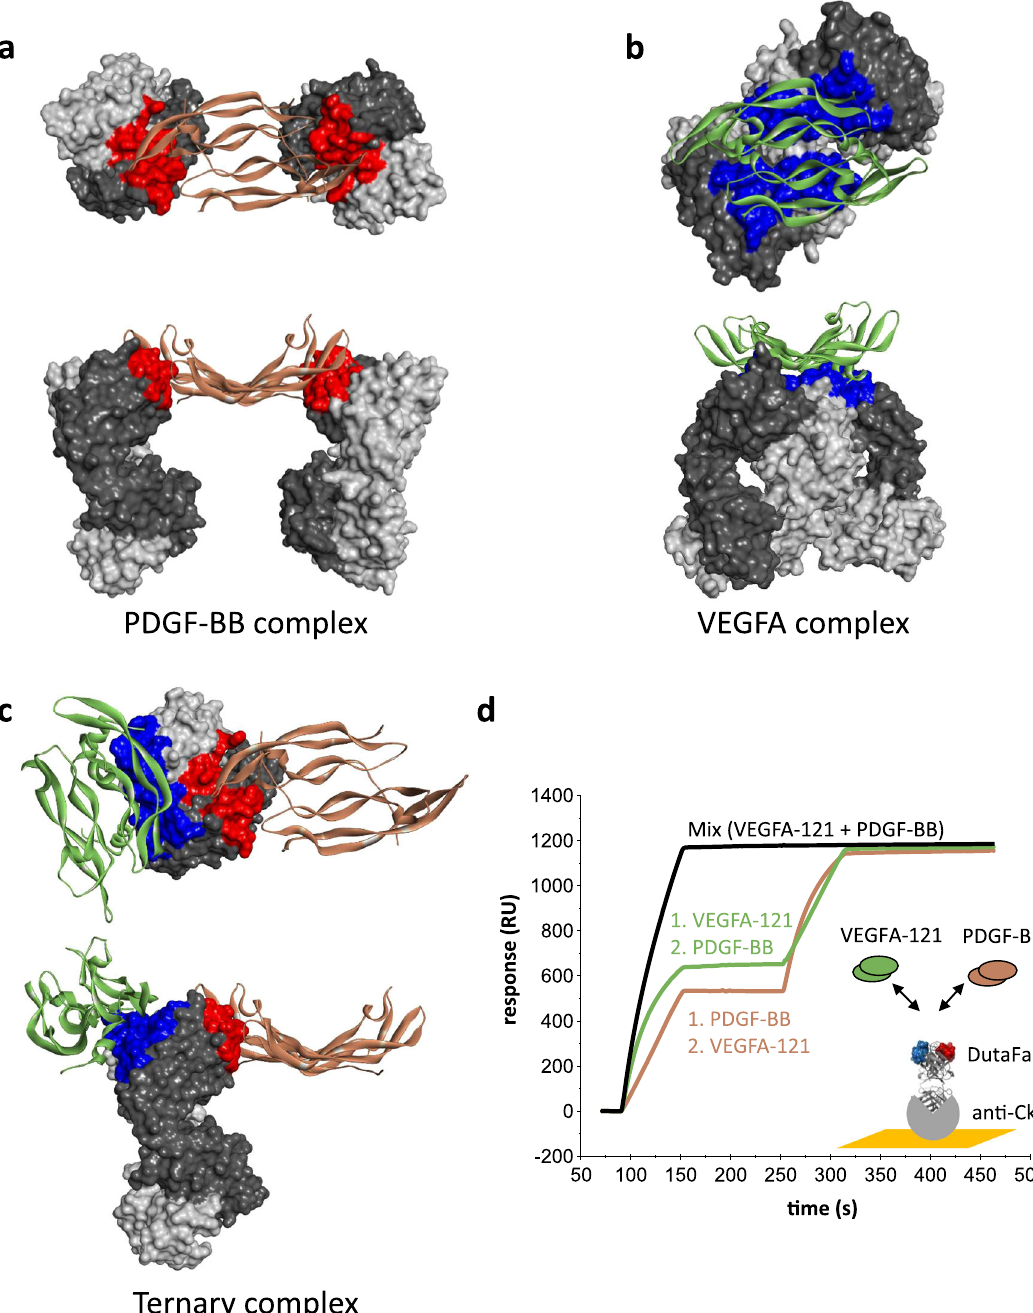
Fig. 4 Structure analysis and co-binding. a X-ray structure of the VP mat DutaFab in complex with PDGF-BB dimer. The Fab is shown in dark gray (heavy chain) and light gray (light chain). The PDGF-BB dimer (beige) binds to the H-side of the DutaFab with the interacting paratope depicted as red surface. The Fab-target complex is always shown in a view from the top and a view from the side. b X-ray structure of the VP mat DutaFab in complex with VEGFA dimer. The VEGFA dimer (green) binds to the L-side of the DutaFab with the interacting paratope depicted as blue surface. c Model of the ternary complex of the VEGF-PDGF DutaFab bound to its two targets simultaneously. The model was constructed by superpositioning the individual structures ( a ) and ( b ) via their Fab domains. d Concomitant binding demonstrated by